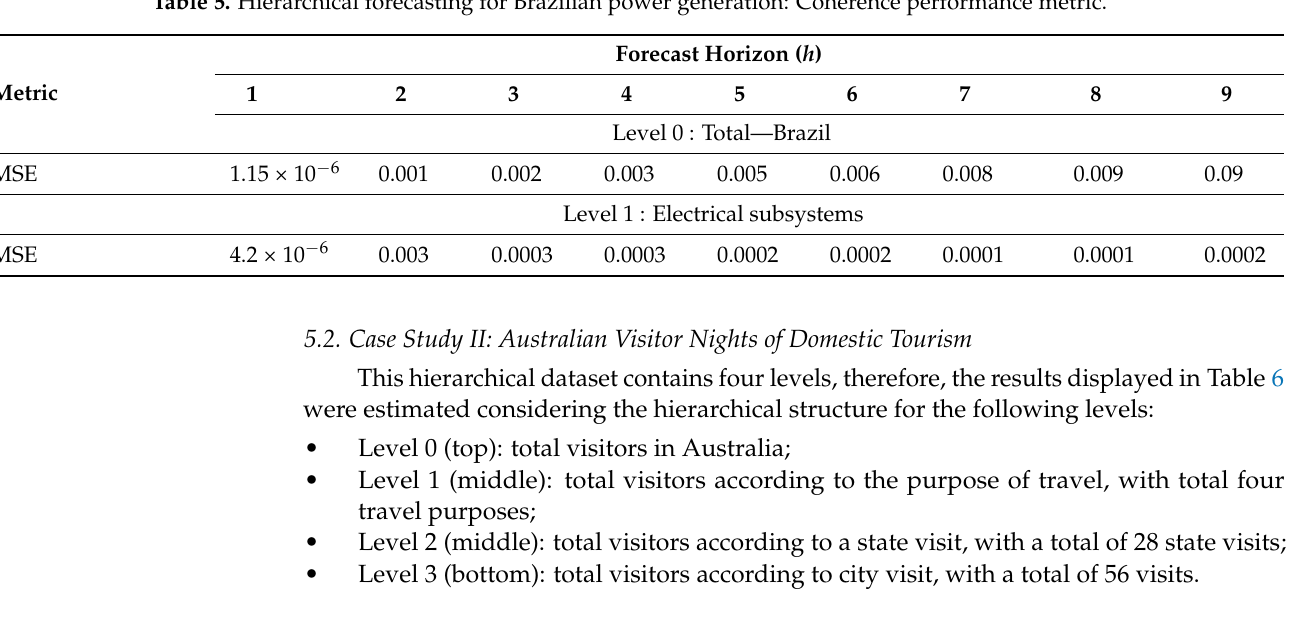
Table 6. Performance comparison based on the MAPE performance metric between the proposed approach and the reference approaches to solve the Australian tourism visitor nights problem as reported in